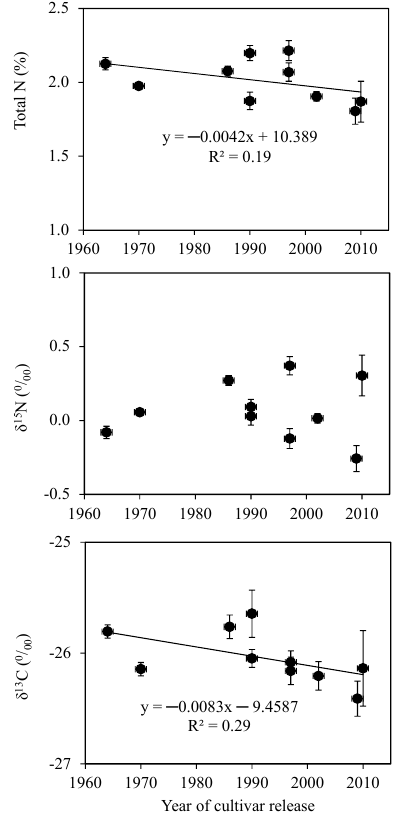
Figure 3. Relationships between the year of release of 10 durum wheat cultivars and the ( A ) total nitrogen, ( B ) natural abundance of 15 N ( δ 15 N) and ( C ) carbon isotope composition ( δ 13 C) in kernels, determined in 2011. Values correspond to the average (±SE) of four replicates.